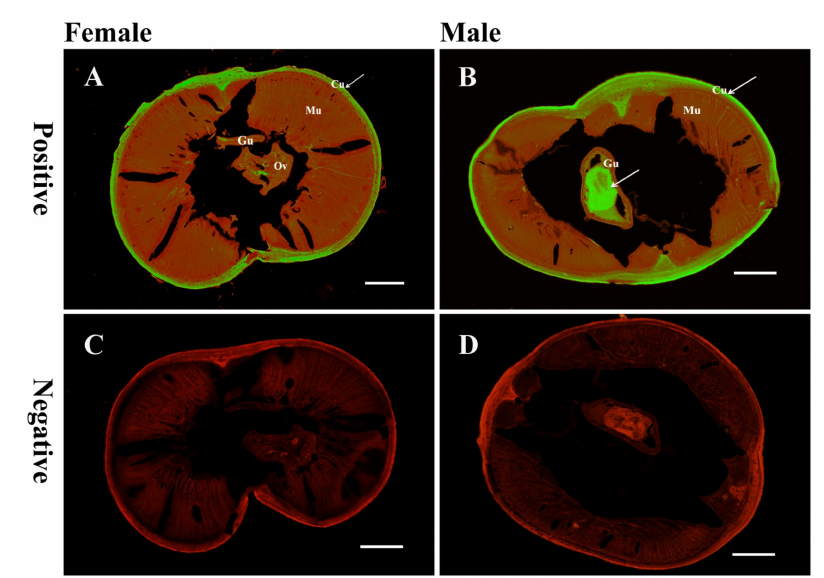
Figure 4. Immunolocalization of native Di -CPI. Both adult female and male worms were probed. The location of native Di -CPI protein is indicated by green fluorescence. Sections (5 µ m) were incubated with either rabbit anti-r Di -CPI IgG at 1:100 ( A and B ) or preimmune IgG at 1:100 ( C and D ), diluted in phosphate-bu ff ered saline (PBS). Arrows indicate a positive signal in the cuticle of female worms (A) and male worms (B) and the gut of male worms (B). No staining was observed for female or male worms using IgG purified from preimmune serum (C and D), confirming specific immunolabeling was achieved. Cu, cuticle; Gu, gut; Ov, ovary. Scale bars = 100 µ